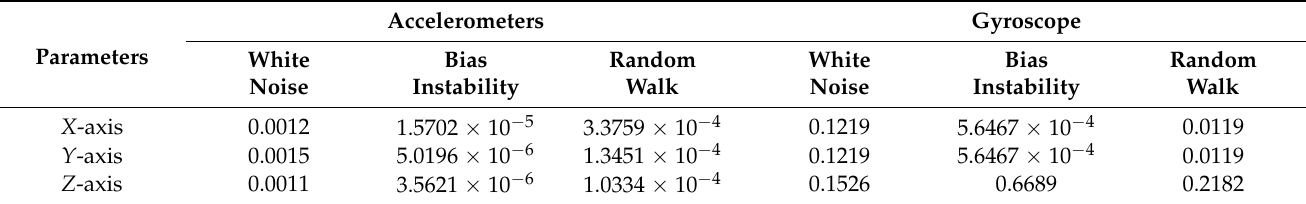
Table 3. Fixed error parameters for accelerometers and gyroscopes.